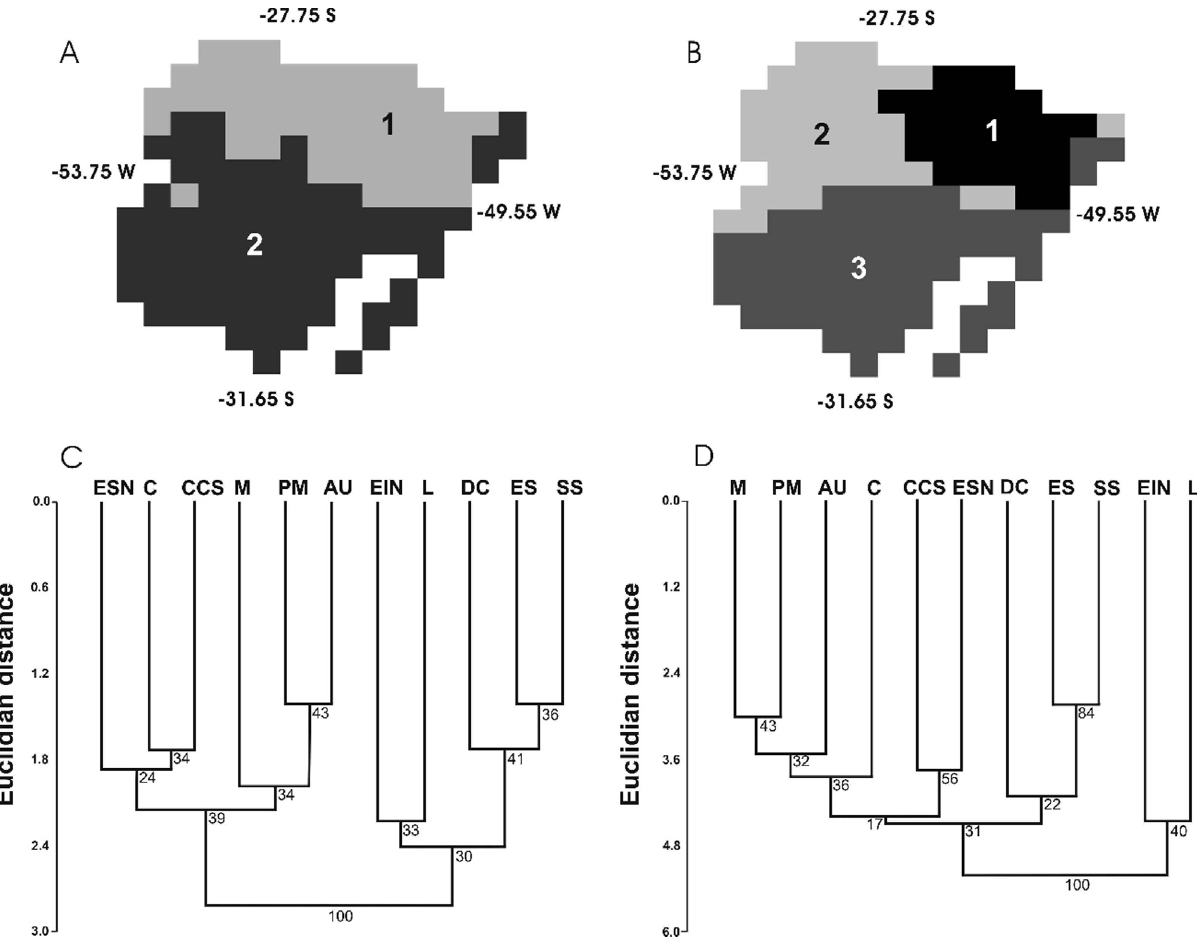
Figure1 -GeographicalclustersderivedfromthefourmostrelevantprincipalcomponentsunderK=2(A)andK=3(B).Clusteranalysesforvegetation groups based on a paired group algorithm using Euclidian distances bootstrapped by 1000 randomizations based on either all Passiflora species occur- rence (C) or Passiflora and Mikania , incorporating the distance matrix from Ritter and Waechter (2004) (D). The physiographical regions according to Fortes (1959): Litoral (L), Depresso Central (DC), Encosta Inferior do Nordeste (EIN), Campos de Cima da Serra (CCS), Encosta Superior do Nordeste (ESN), Misses (M), Planalto Médio (PM), Alto Uruguai (AU), Campanha (C), Serra do Sudeste (SS), and Encosta do Sudeste (ES). Table 1 - The most relevant niche contributors identified by principal component analysis. The values of environmental variables were extracted for each grid cell. Here we present the four principal components, which explained most of the total environmental variance (91.66%). The variance (V) and eigenvalues (E) are shown for each PC, while we presented the loadings (L) for each identified contributor. V